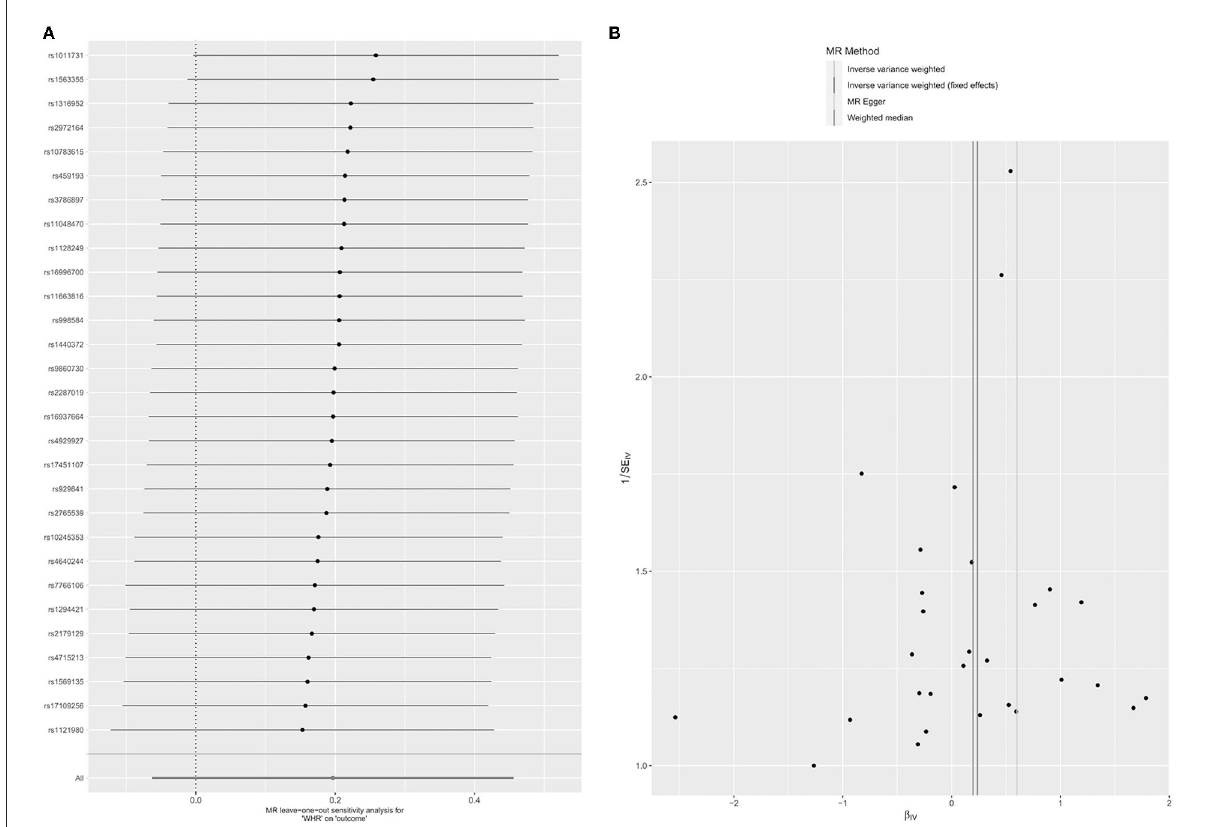
FIGURE4 Leave-one-out permutation analysis plot (A) and Funnel plot (B) of WHR.